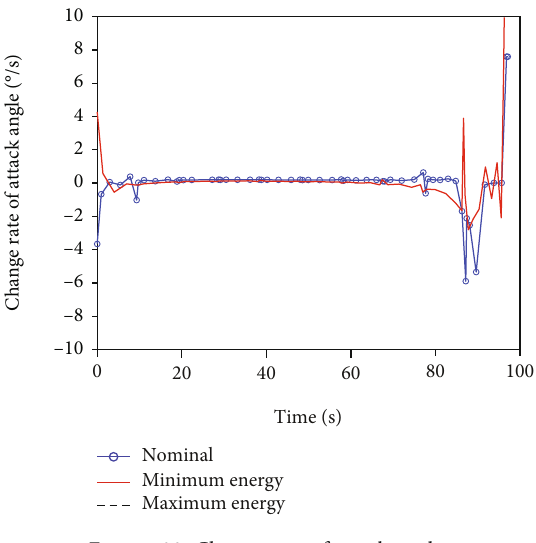
Figure 28: Change rate of attack angle.